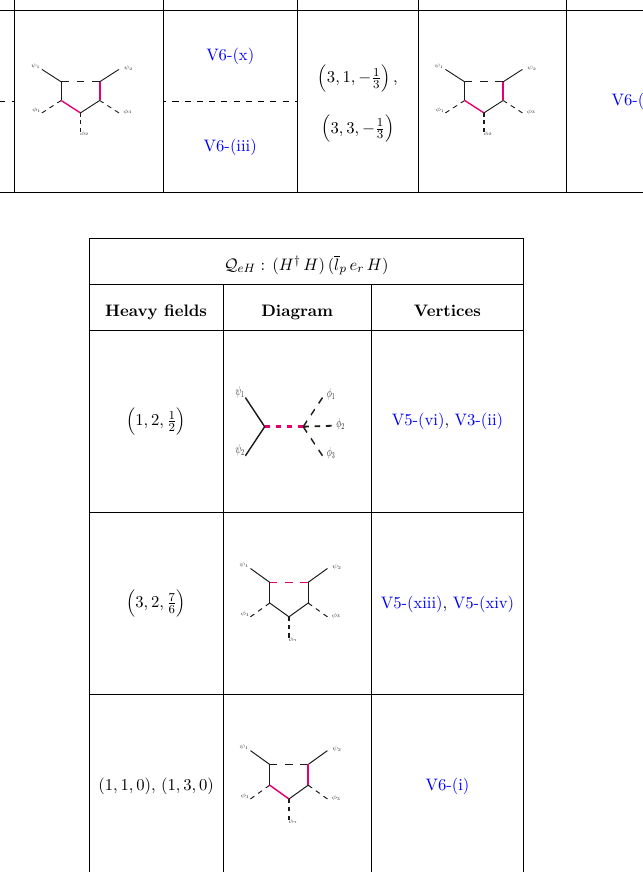
Table 7 . Heavy field representations that are obtained by unfolding the ψ 2 φ 3 operators into non- trivial tree- and (or) one-loop-level diagrams and the corresponding